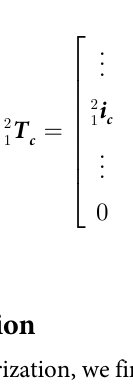
) of the regularized ASA ASA